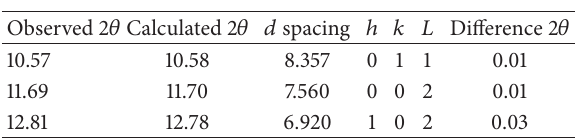
LCl (H O) ]. 2 2 2 6 L 󸀠 Cl (H O) ]. 2 2 2 6